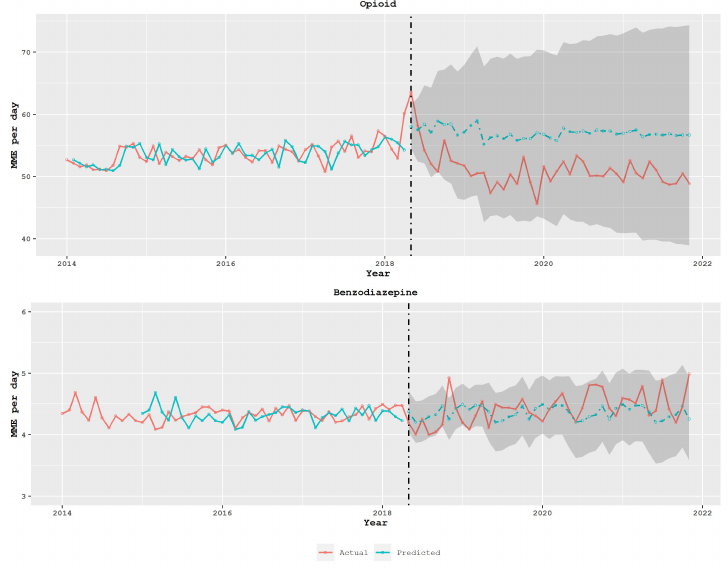
Figure 5. The top graph shows the average daily MME for opioid prescriptions in the state of South Carolina over a period of time (measured in months). The broken vertical line indicates the legislative intervention that was enacted in May 2018. The blue dotted line in the graph represents the fit of the mathematical model. The bottom graph demonstrates the same for benzodiazepine as the control